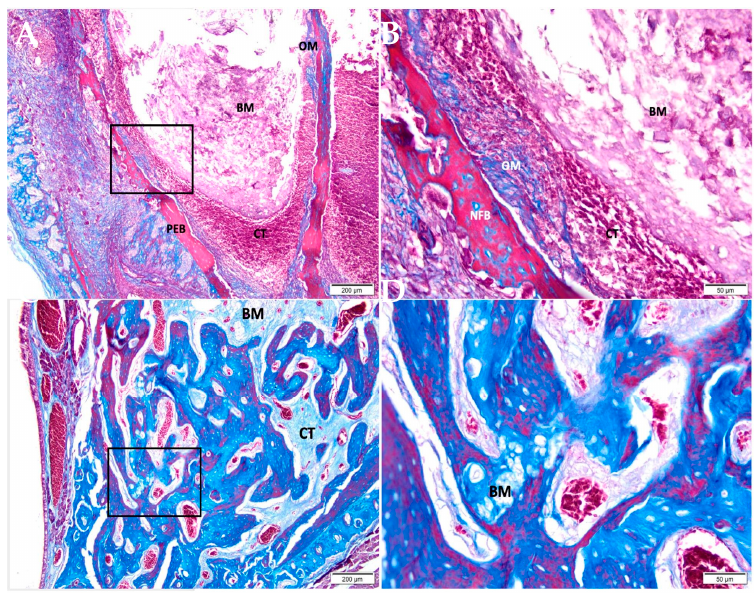
Figure 3. Photomicrographs of the CHA group 7 and 42 days after alveolar grafting. ( A , B ): 07 days; ( C , D ): 42 days; ( A , C ): 10× magnification (Bar: 200 μ m); ( B , D ): 40× magnification (Bar: 50 μ m); Stain: Masson’ trichrome. Biomaterial (BM); Connective Tissue (CT); Pre-Existing Bone (PEB); Newly Formed Bone (NFB).